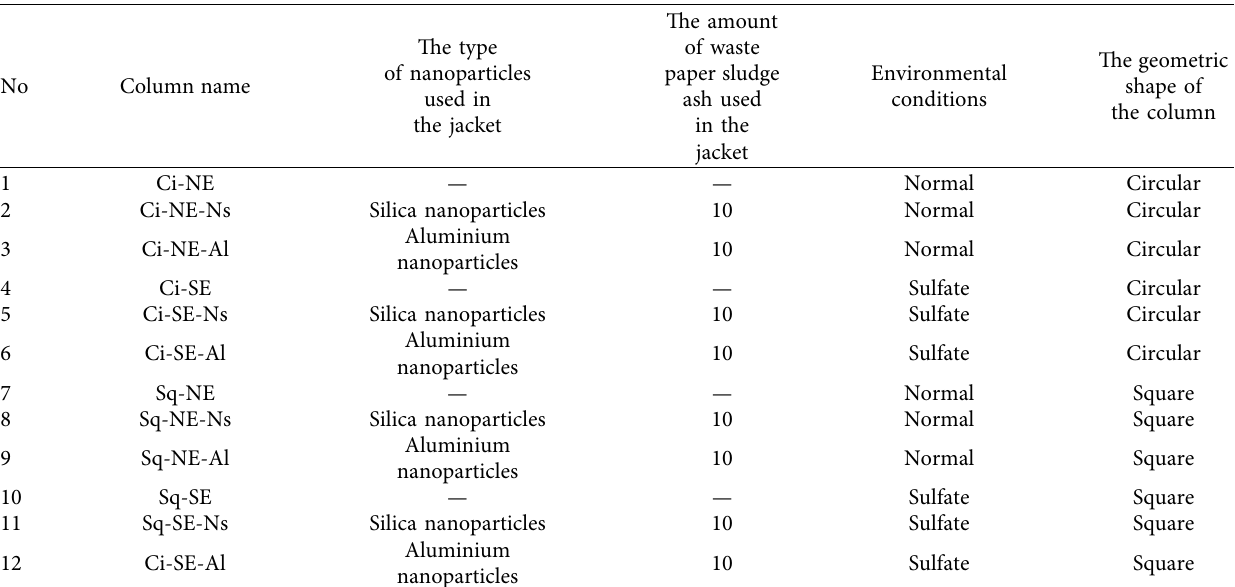
Table 2: Te desired columns and